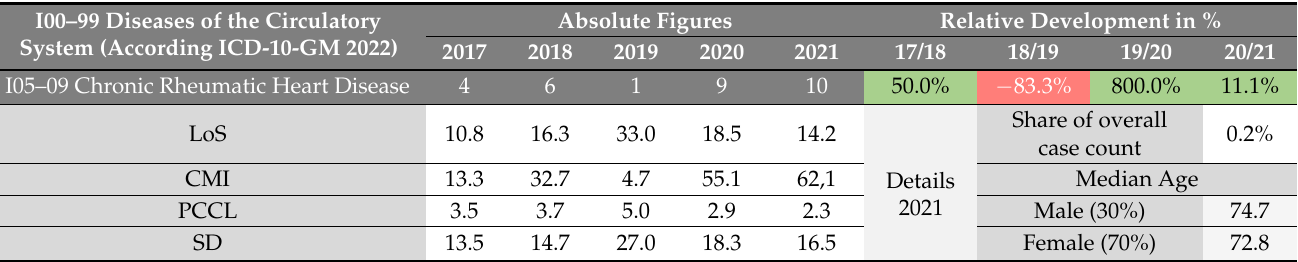
Table 3. Yearly absolute and relative development of cardiovascular sub-disciplines,